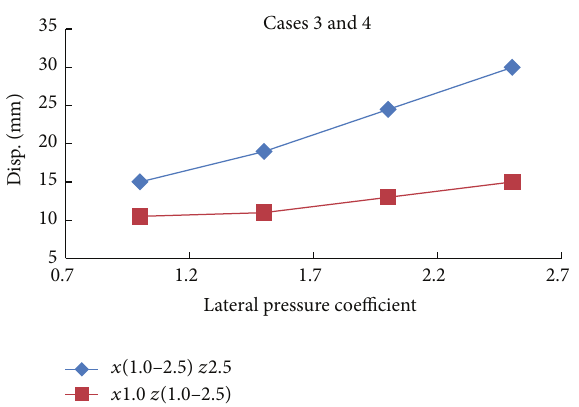
Figure 14: Key point displacement in side wall versus lateral pressure coefficient in cases 3 and